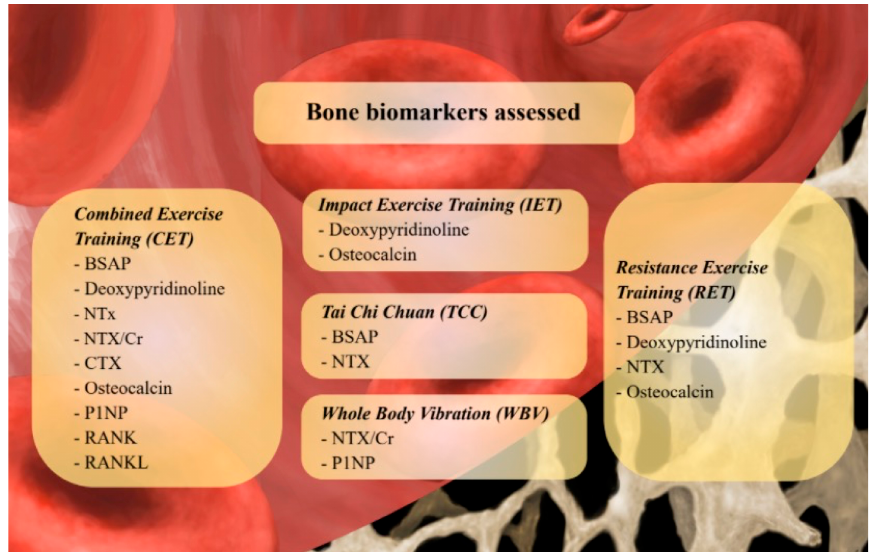
Figure 2. Bone biomarkers proposed in the current literature to assess the effects of different exercise modalities. Abbreviations: BSAP: Bone Specific Alcaline Phosphatase; CTX: Cross ‐ linked Collagen